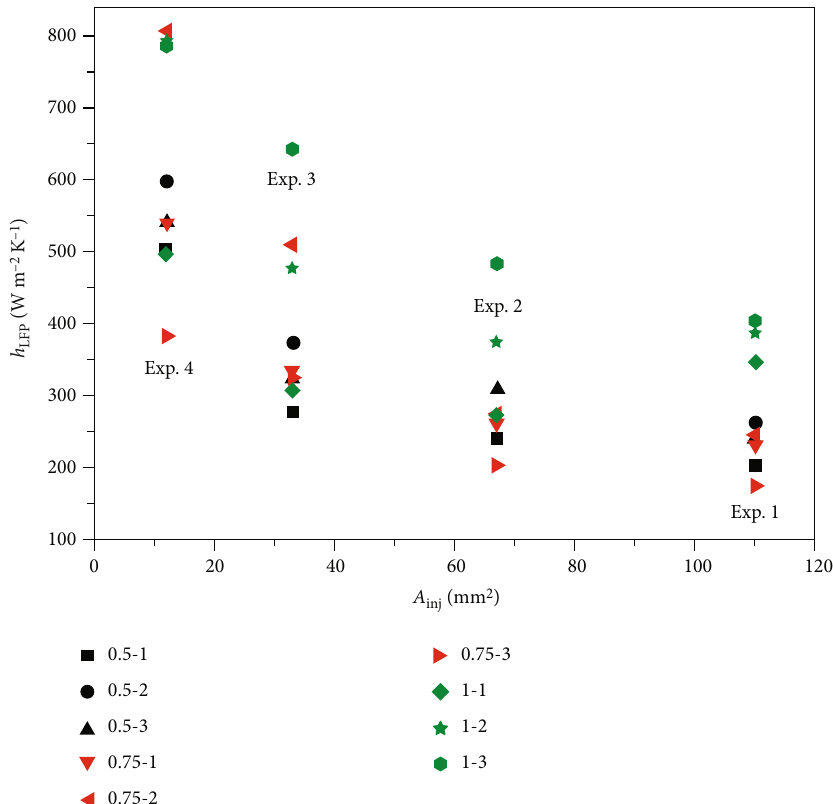
Figure 12: Experimental h